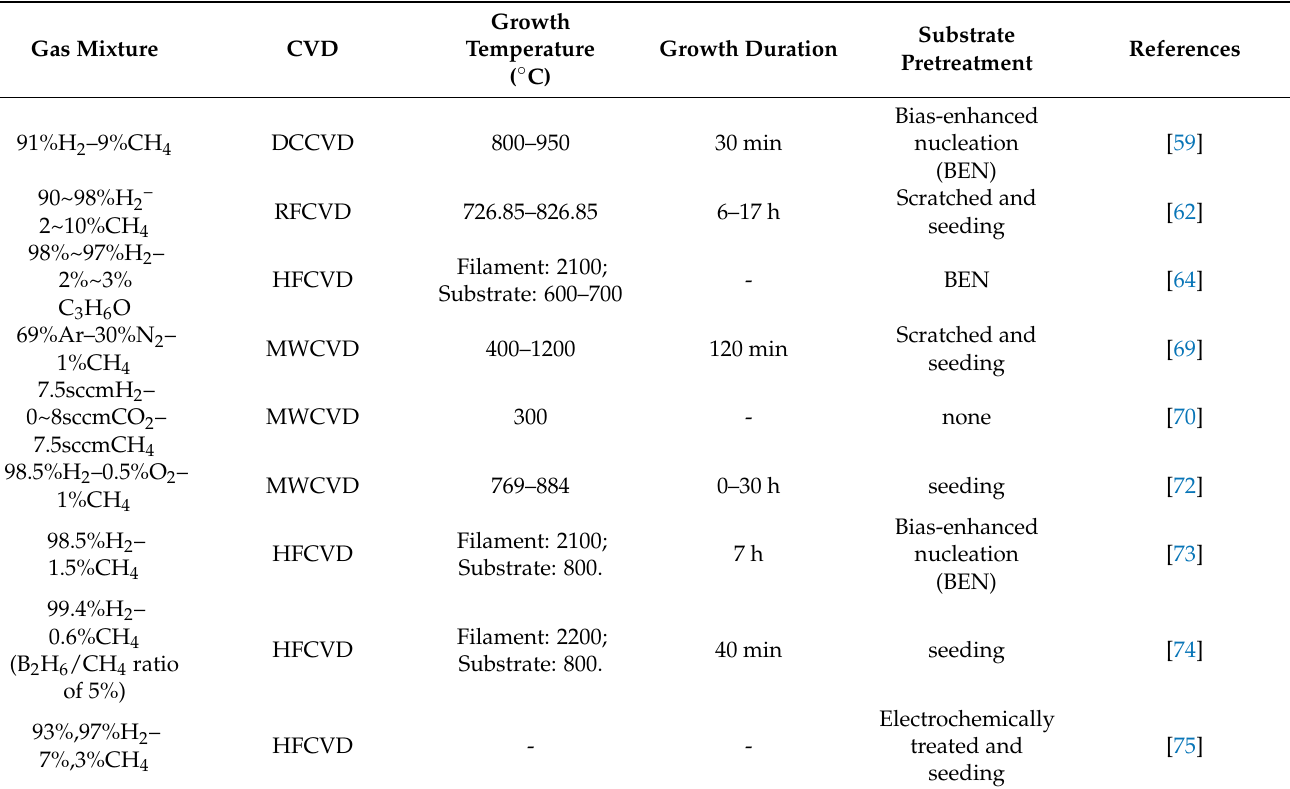
Table 1. Summary of the key growth parameters for the ND films by CVD with different energy